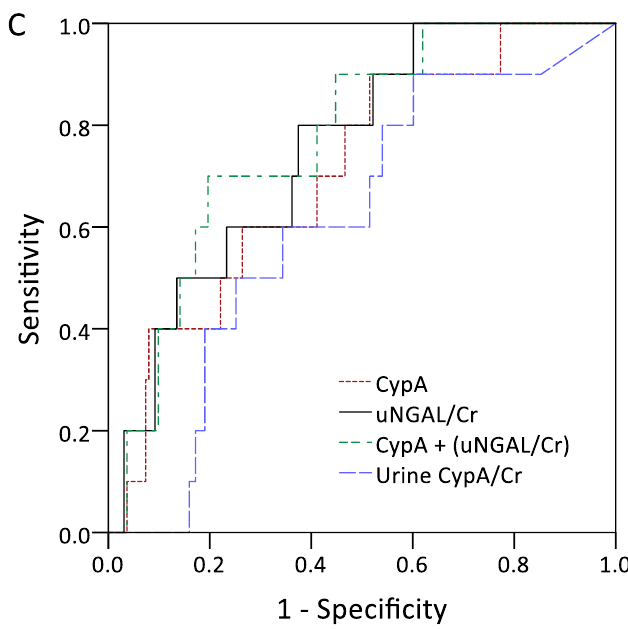
Figure 2. Area under the curves for serum CypA, urine NGAL normalized by urine Cr, serum CypA plus urine NGAL normalized by urine Cr, and urine CypA normalized by urine Cr in discriminating acute kidney injury ( A ), dialysis-requiring acute kidney injury ( B ), and 90-day mortality ( C ). Abbreviations: CypA, cyclophilin A; NGAL, neutrophil gelatinase-associated lipocalin; Cr, creatinine.